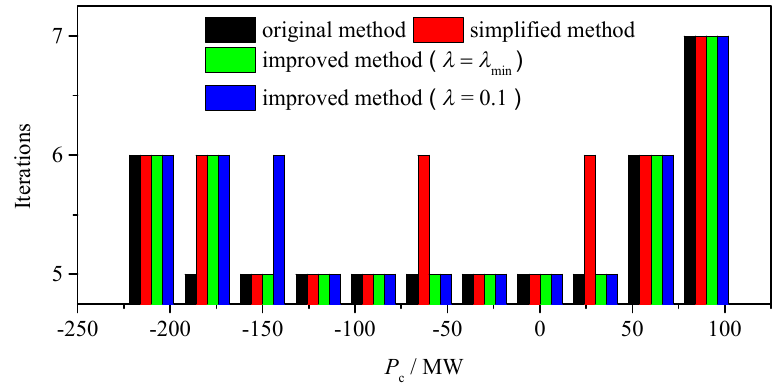
Figure 7. The iteration numbers of the test system with the conventional structure UPFC.